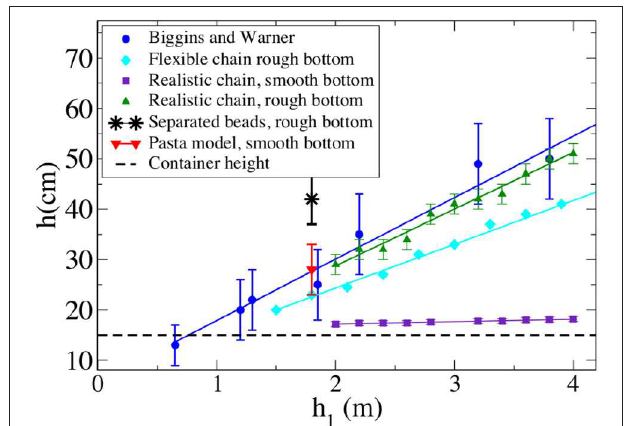
FIGURE 11 | The fountain height as a function of elevation h 1 for the different models. Reproduced from Flekkøy et al. [10] with permission from the authors.